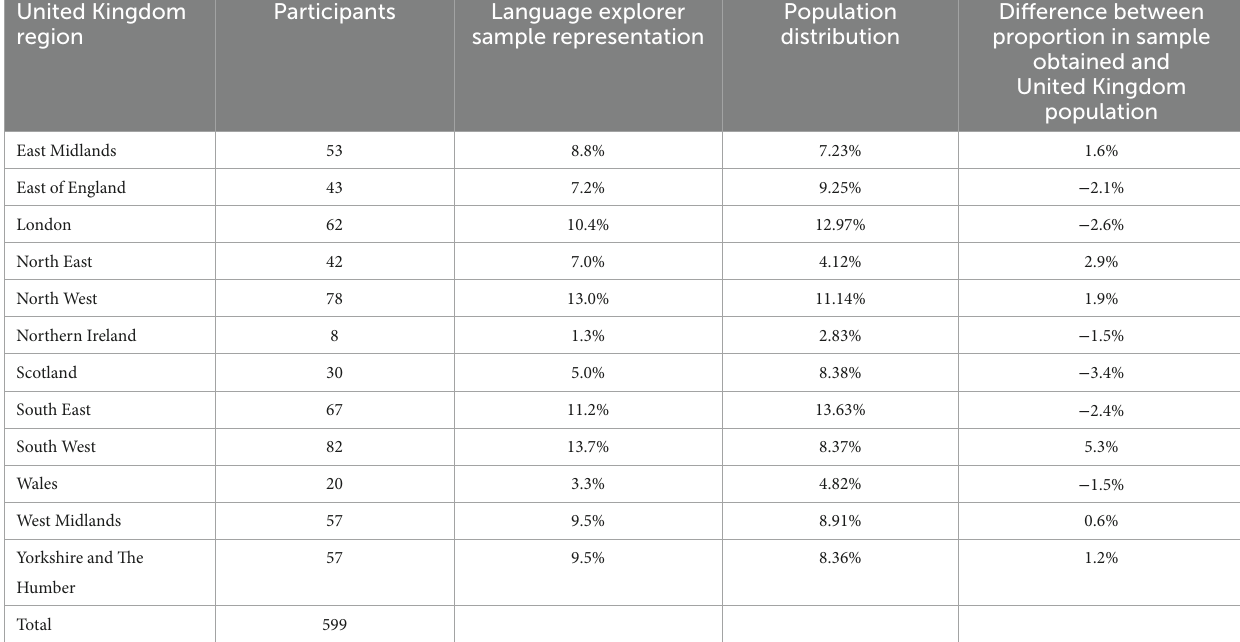
TABLE 2 Participant geographical location based on partial postcode compared with population